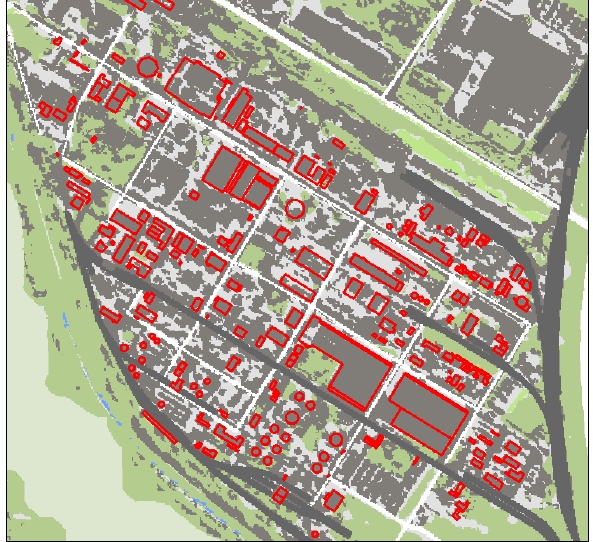
Figure 7. Combination of ESM with afterwards added